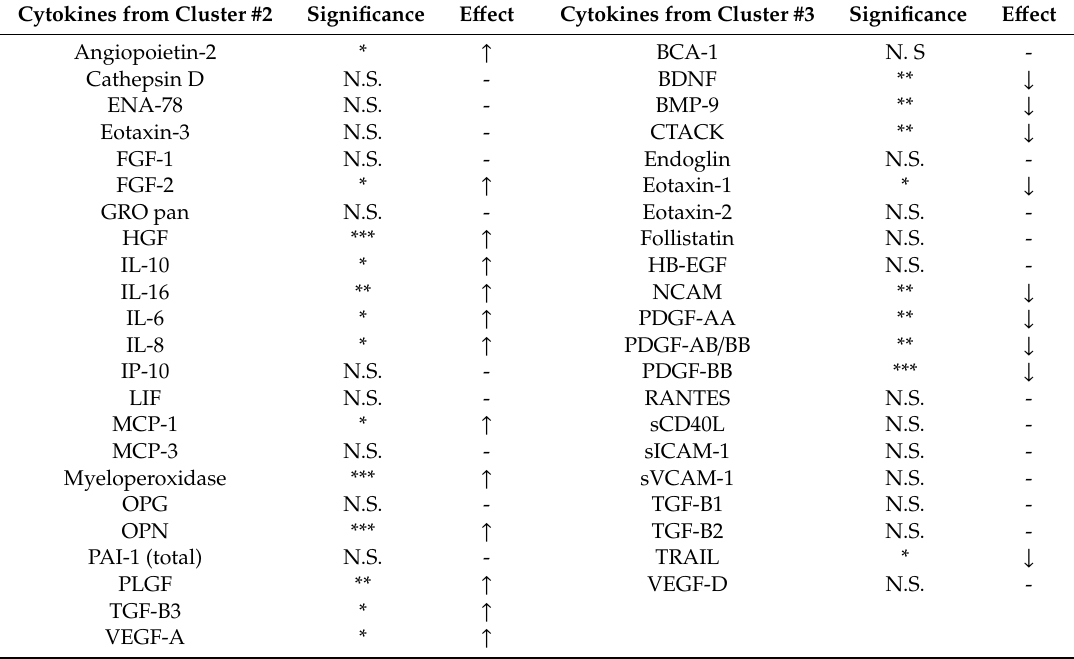
Table 3. Statistical significance and effect of cytokines from multiplex ELISA assay ( cluster #2 and cluster #3 ) contributing the most to the variance observed between HH-# versus Hema-# patients. Cytokines from Cluster